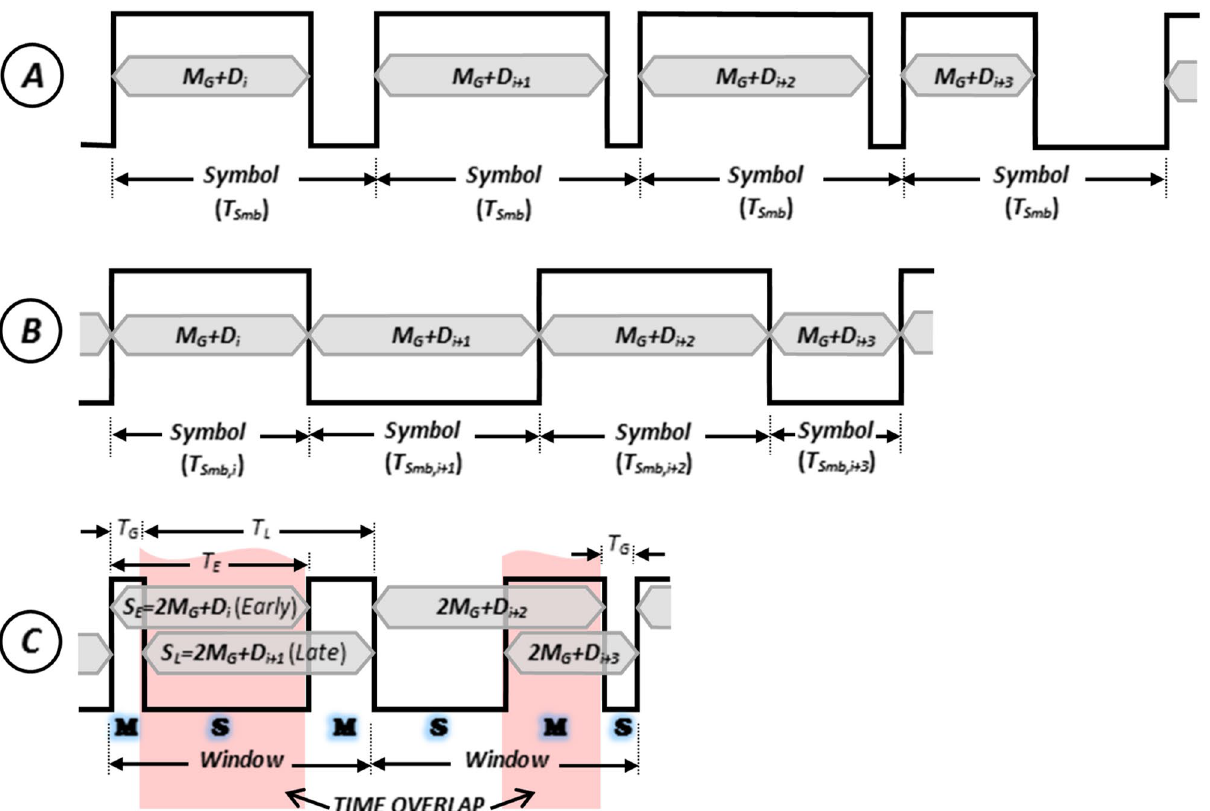
Figure 1. Illustration of the proposed compressive telemetry scheme in comparison with other pulse-time modulation schemes. ( a ) Pulse-width modulation, ( b ) Pulse Interval and width modulation, ( c ) Intertwined- pulse modulation (the proposed